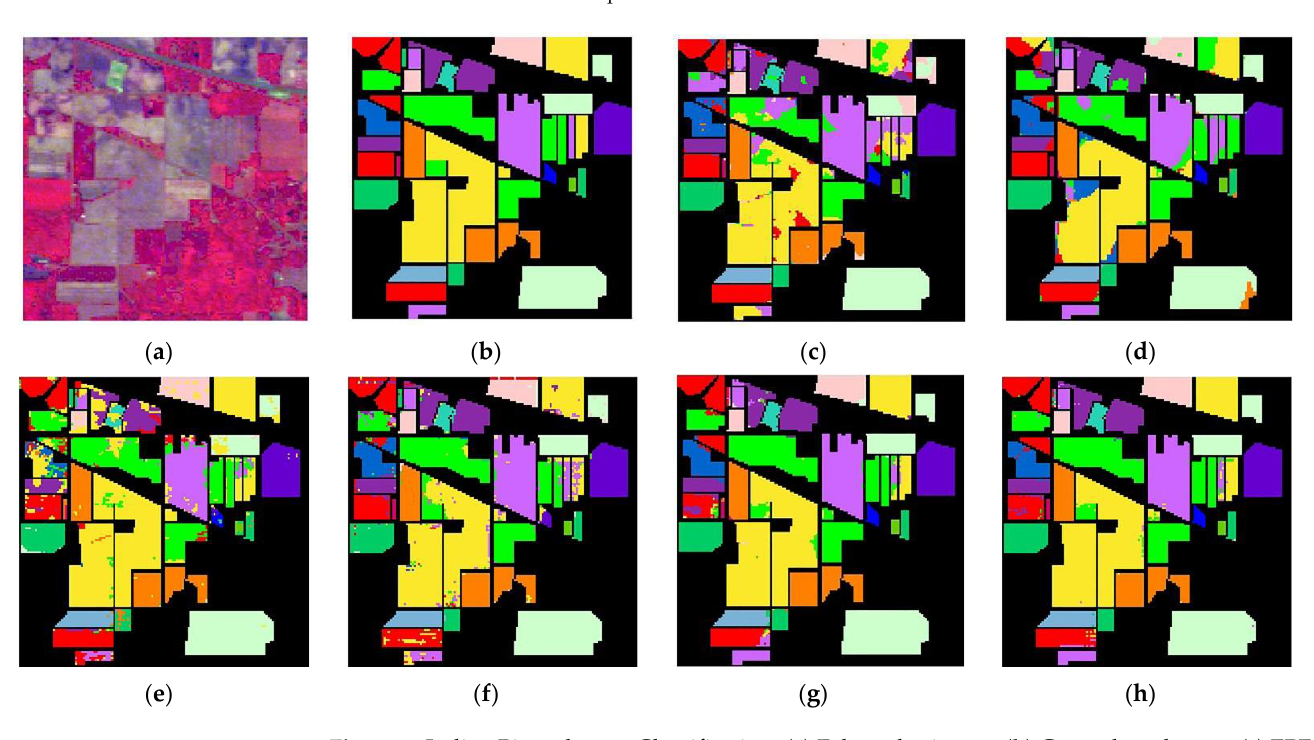
Figure 8. Indian Pines dataset Classification: ( a ) False color image, ( b ) Ground-truth map, ( c ) EPF, ( d ) IFRF, ( e ) RPNET, ( f ) CNN-AL, ( g ) SS-RMG, and ( h ) Improved-ADL. Table 6. Classification results of different methods on the Indian Pines dataset.